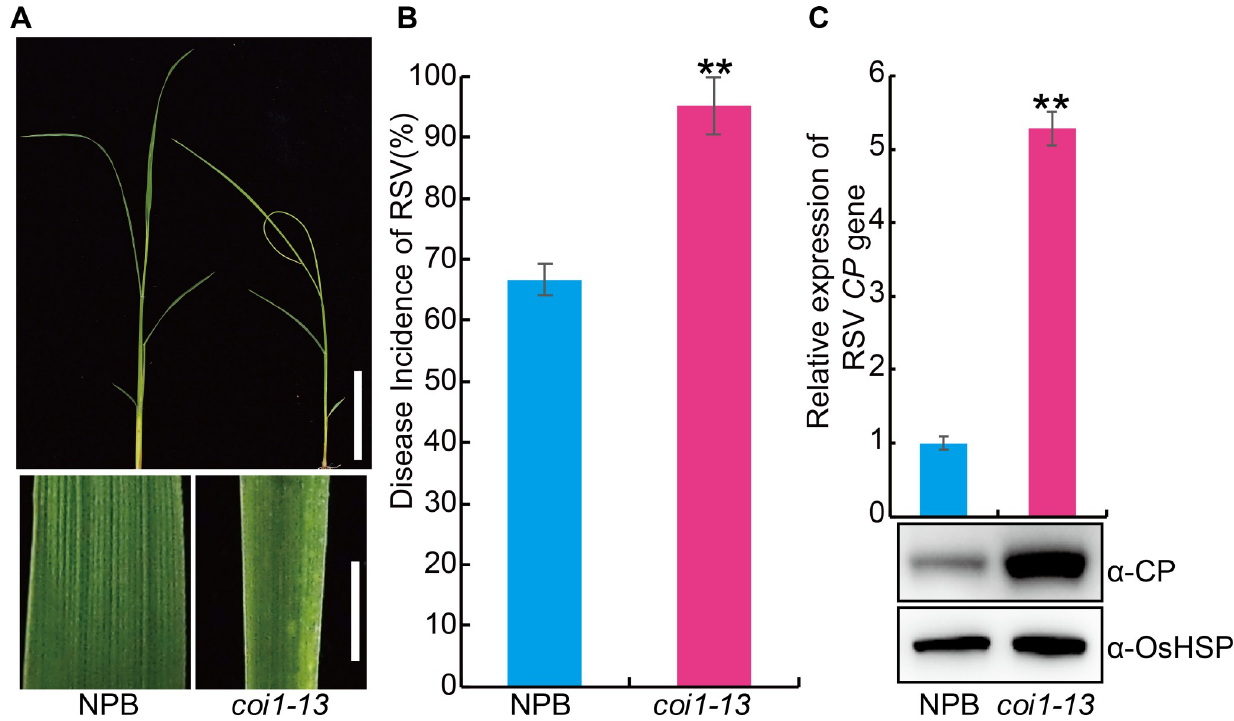
Fig 6. Knockdown of OsCOI1 expression significantly increases the susceptibility to RSV in rice. (A) Representative image of the JA co-receptor OsCOI1 RNAi line ( coi1-13 ) and the wild-type Nipponbare (NPB) seedlings infested with RSV-carrying SBPH. Bar = 5 cm (top). Bar = 3 mm (bottom). (B) RSV incidence of NPB and coi1-13 seedlings at 30-day post infection (dpi) with RSV-carrying SBPH. (C) Detection of RSV CP RNA expression levels (upper panel) by quantitative RT–PCR assay and western blot analysis of the RSV coat protein (lower panel) in the RSV-infected NPB and coi1-13 seedlings, respectively. OsHSP was used as loading control. Data are shown as mean ± SEM (n = 3). �� P < 0.01 by Student’s t -test in B and C.